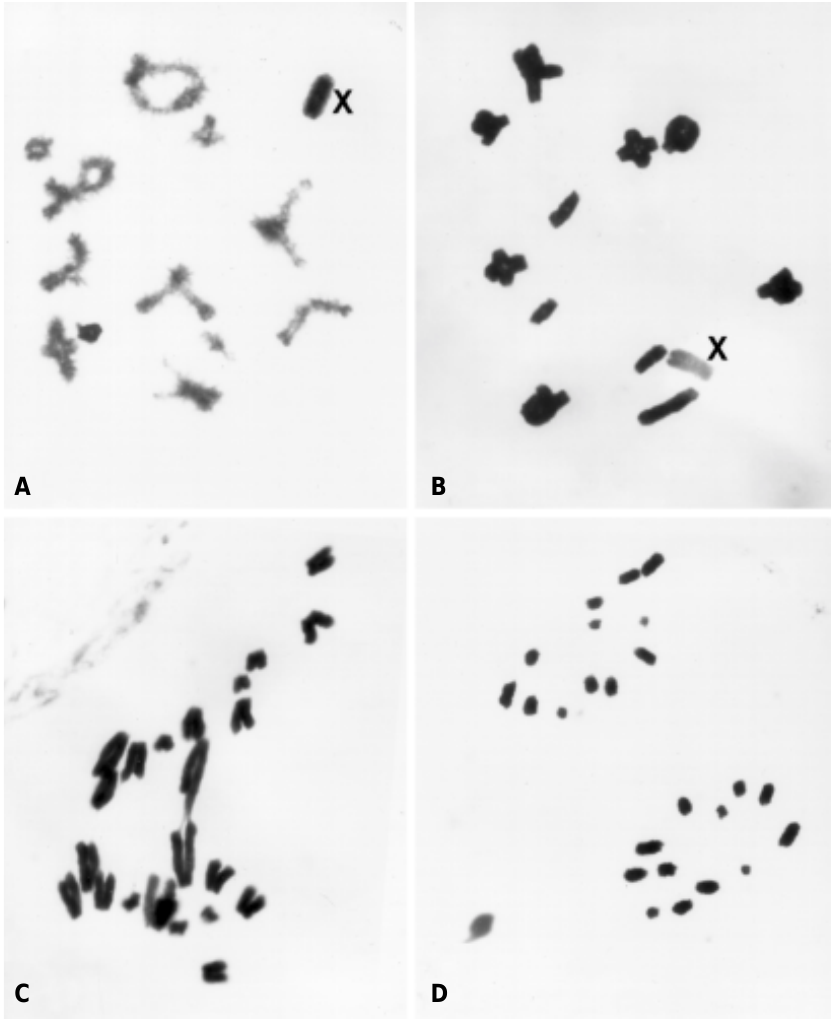
Figure 1 - Conventional staining with lacto-acetic orcein of meiotic cells of Belosacris coccineipes . A ) Diplotene, B ) metaphase I, C ) anaphase I and D ) anaphase II with 12 chromosomes. Note the X chromosome which is heteropycnotic positive in A and negative in B.